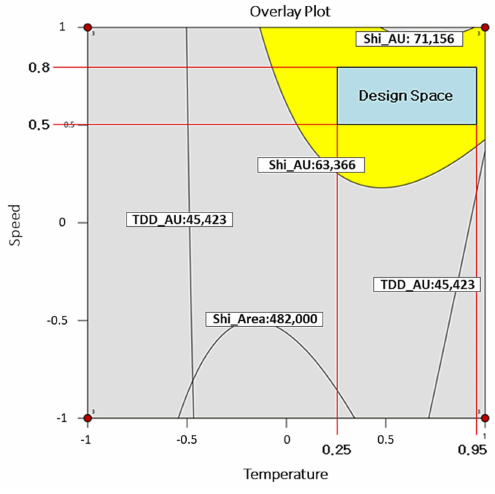
Figure 8. Final design space (DS) without 95% confidence interval. Table 4. Optimization target value, upper and lower limit by ORVs.